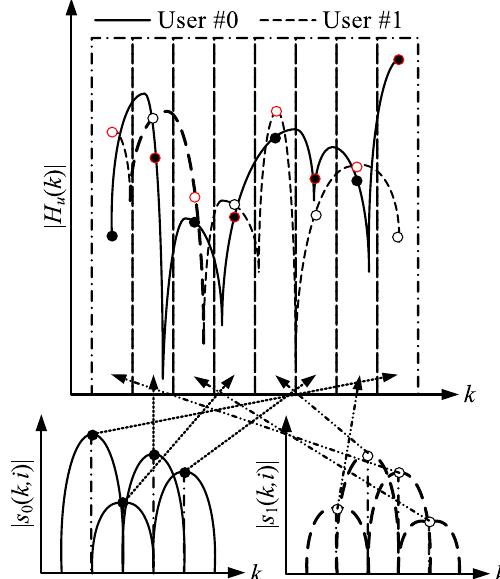
Fig. 5 Example of the proposed interleaved block subcarrier allocation and power combination for N c = 8 , N u = 2 , and I =